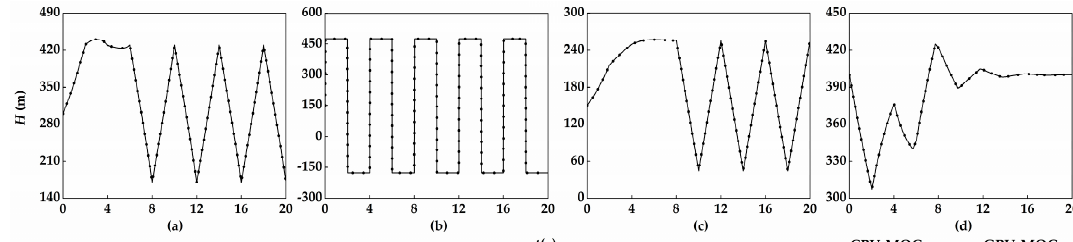
Figure 2. Pressure curves at the valve for GPU-MOC and CPU-MOC method: ( a ) first-phase water hammer; ( b ) direct water hammer; ( c ) last-phase water hammer; and ( d ) negative water hammer. H denotes head and t denotes time.